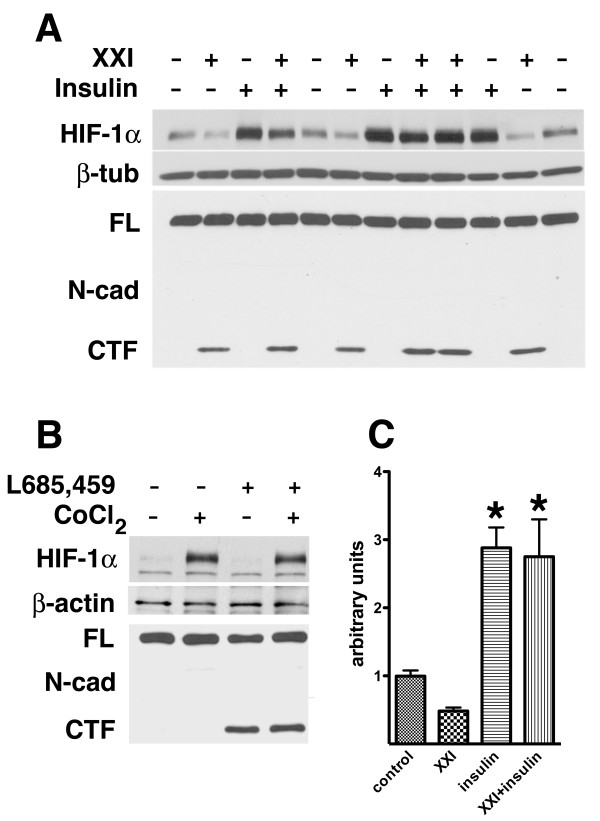
γ-secretase activity is not needed for insulin or cobalt induction of HIF-1α. Psen1+/+ immortalized fibroblasts (A) were treated overnight with the γ-secretase inhibitor XXI and then stimulated with insulin for 6 hours. Western blotting for HIF-1α was performed (upper panel) followed by reprobing of the blot for β-tubulin (middle panel). The same samples were then reblotted and probed for N-cadherin (lower panel). A band for the full length N-cadherin (FL) is indicated. A band that corresponds to the N-cadherin CTF is visible in the γ-secretase inhibitor treated lanes. In panel B, Psen1+/+ fibroblasts were treated overnight with the γ-secretase inhibitor L-685,458 and then stimulated with cobalt chloride for 6 hours. The samples were blotted and probed for HIF-1α (upper panel) and β-actin (middle panel) and then reblotted and probed for N-cadherin (lower panel). In panel C, the experiment in (A) was quantitated with the levels of HIF-1α normalized to β-tubulin. Analysis of the data in panel C (n = 3 per group) revealed significant increases in HIF-1α following treatment with insulin vs. untreated control (p = 0.004, unpaired t-test) or XXI treated vs. insulin + XXI (p = 0.01). There was no difference between insulin treated vs. insulin plus XXI treated cultures (p = 0.29) although XXI treatment alone modestly decreased HIF-1α levels vs. untreated control (p = 0.006). Representative experiments are shown. Asterisks (*) indicate values that are significantly different from corresponding samples that were not treated with insulin.